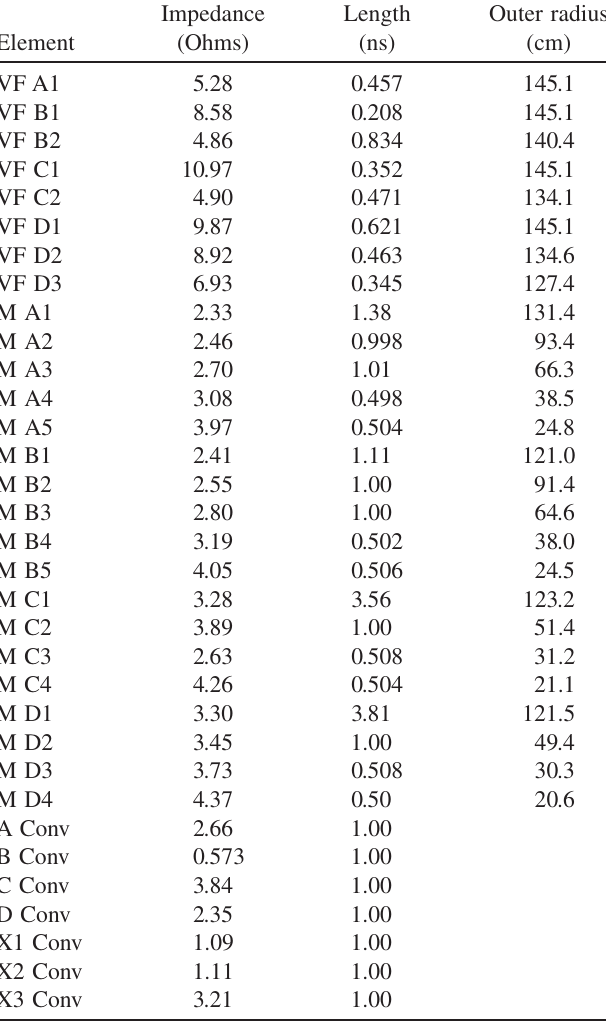
TABLE I. Circuit element parameters used in the vacuum section of the model. The MITL currents shown in Fig. 3 are measured across elements M A2, M B2, M C1, and M D1. The effective outer radius for each of the vacuum flare and MITL elements is also